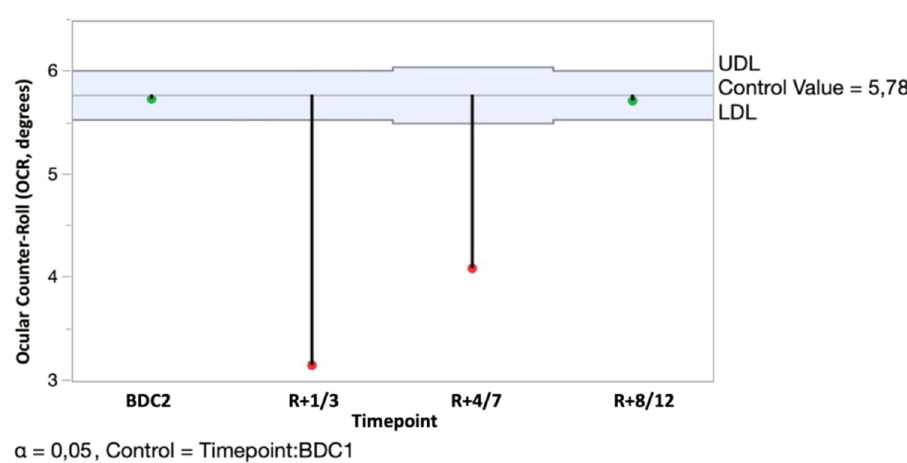
Fig. 7 The post hoc Dunnett ’ s test. Timepoint BDC1 was taken as the reference, this post hoc analysis shows the signi fi cant difference between the fi rst two post fl ight ( R + 1/3 and R + 4/7), whereas both pre fl ight (BDC2) and last post fl ight ( R + 8/12) measurements are not signi fi cantly